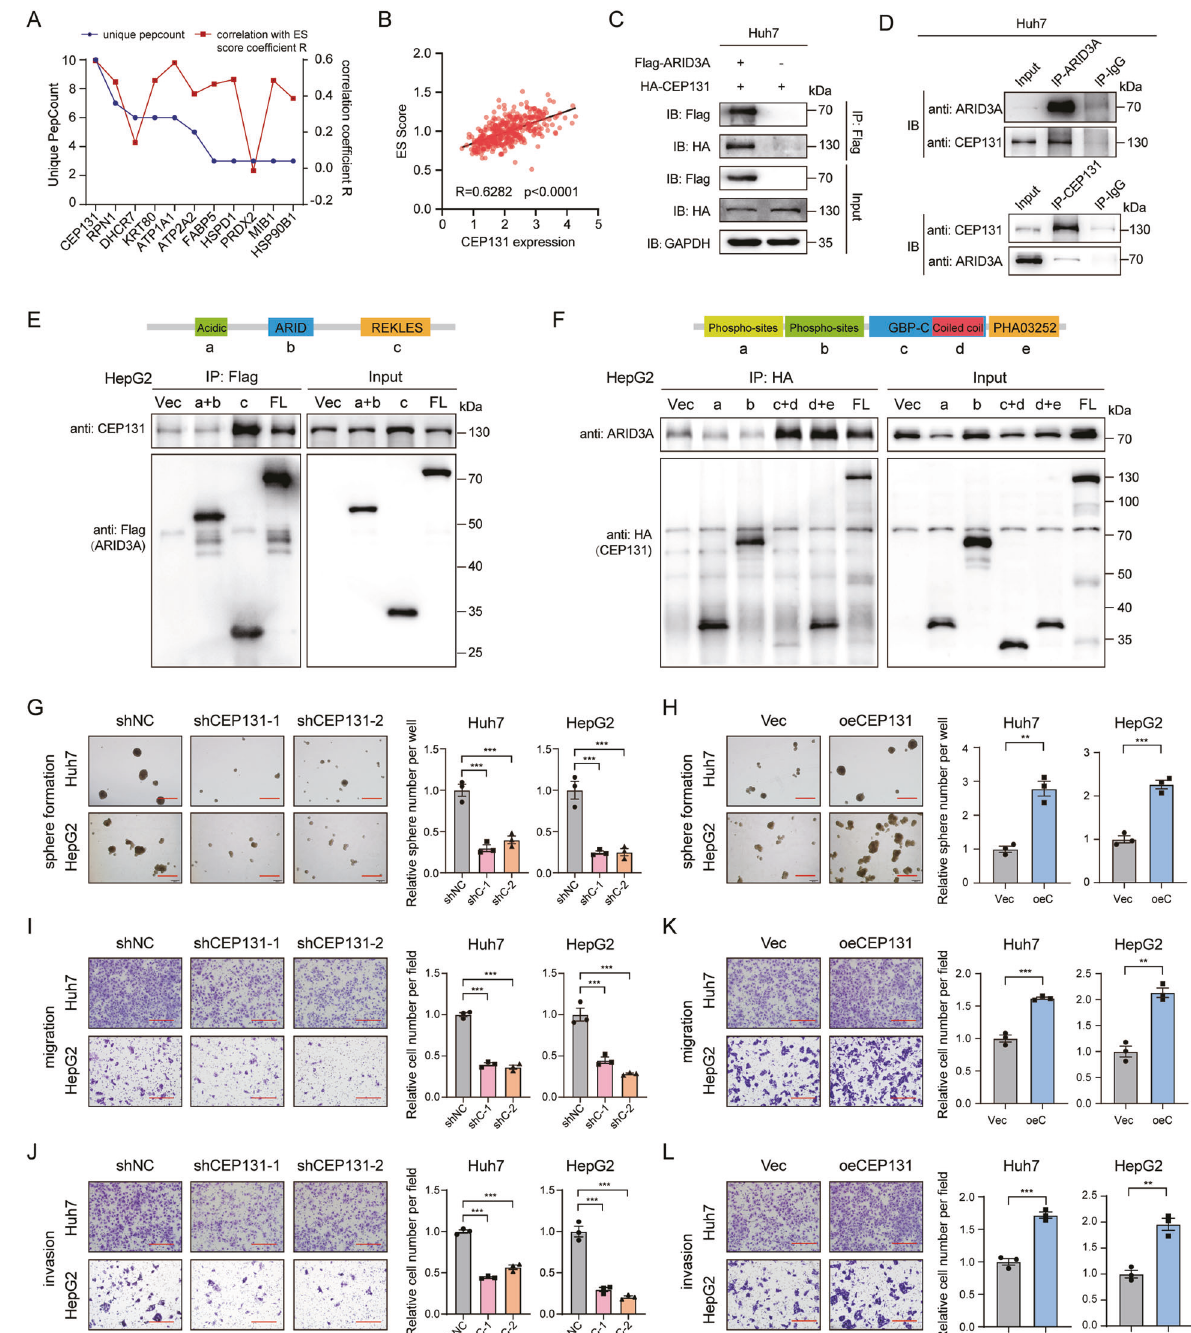
Fig. 5 ARID3A interacts with CEP131 in liver cancer cells. A Unique peptide counts and ES scores of ARID3A-associated genes identi fi ed by Co-IP/LC-MS. B Correlations between ES scores of individual patient samples and CEP131 expression levels were determined from TCGA-LIHC data. n = 374, Spearman ’ s rank correlation analysis. C Veri fi cation of the interaction between exogenously overexpressed ARID3A and CEP131 in Huh7 cells by Co-IP. Anti-Flag antibody-captured CEP131. D Veri fi cation of the interaction between endogenous ARID3A and CEP131 in Huh7 cells by Co-IP. Top, anti-ARID3A antibody-captured CEP131; bottom, anti-CEP131 antibody-captured ARID3A. E , F Schematic diagrams of the ARID3A ( E ) and CEP131 ( F ) truncation mutants based on their structural domains. Western blotting was performed to determine the immunoprecipitation ef fi ciency of Flag-tagged ARID3A and HA-tagged CEP131 in HepG2 cells. G , H Tumoursphere formation assays of liver cancer cells after CEP131 knockdown (shNC as the control) ( G ) and overexpression (Vec as the control) ( H ) (scale bar, 300 μ m). n = 3 biologically independent experiments, one-way ANOVA with Tukey ’ s multiple comparison test or two-tailed Student ’ s t -test. I – L Transwell migration and invasion assays of liver cancer cells with CEP131 knockdown (shNC as the control) ( I , J ) and overexpression (Vec as the control) ( K , L ) (scale bar, 150 μ m). n = 3 biologically independent experiments, one-way ANOVA with Tukey ’ s multiple comparison test or two-tailed Student ’ s t -test.